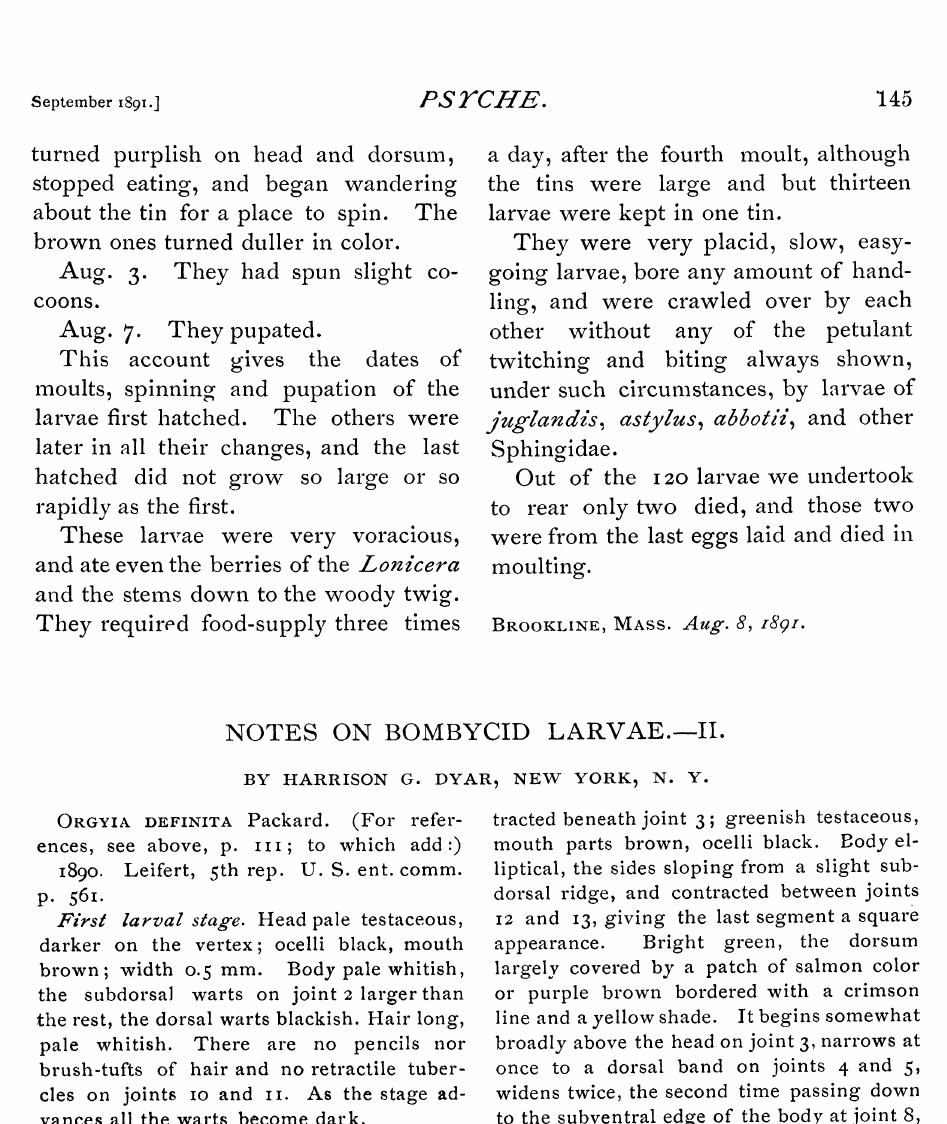
row of blackish spots. Length 9